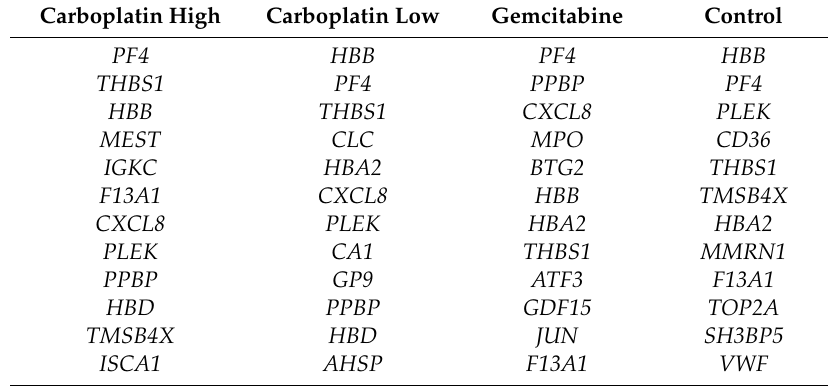
Figure 3. Venn diagrams showing the overlap between the treatment conditions Carboplatin High, Carboplatin Low, Gemcitabine, and Control. ( a ) The top 100 and ( b ) the top 2000 most variable genes.